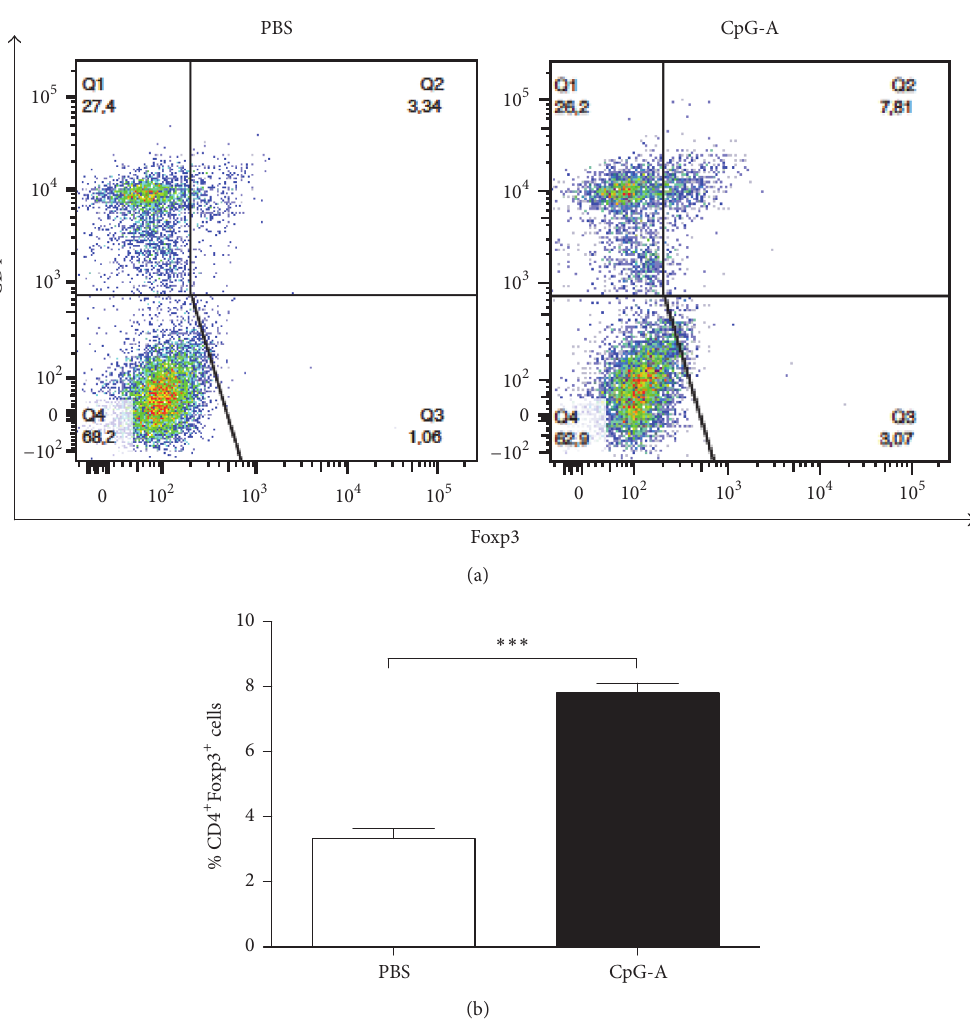
Figure 5: CpG-A treatment increases CD4+ Foxp3 Treg cell differentiation in EAE mice. (a) Flow cytometry analysis of CD4 + and Foxp3 +